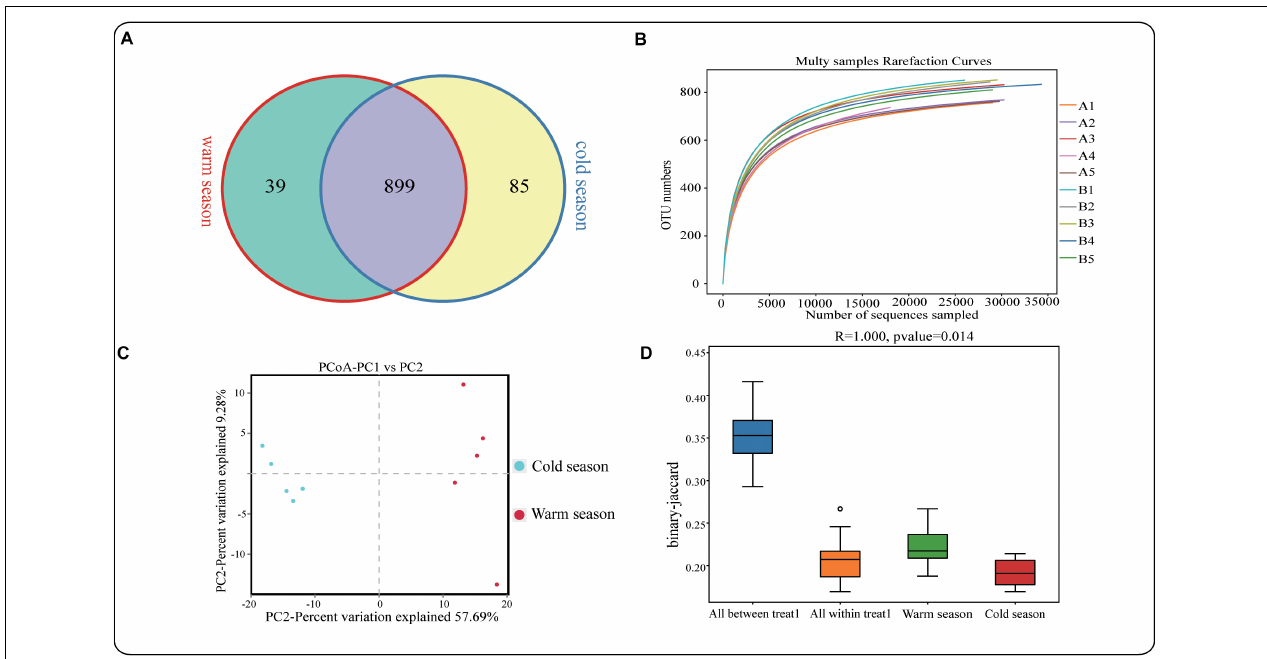
FIGURE 1 | (A) OTU-Venn diagram analysis of cold and warm seasons; (B) Dilution curve analysis; (C,D) PCoA and Anosim analysis.